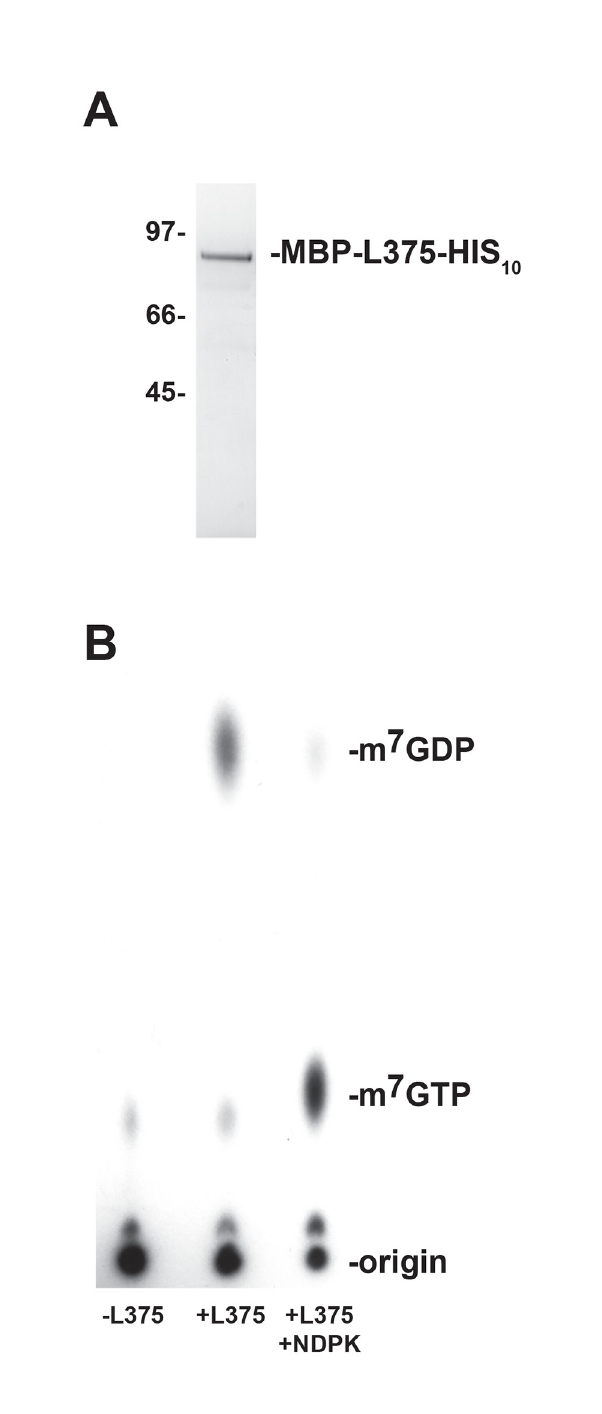
Fig 2. Recombinant Mimivirus L375 hydrolyzes the mRNA cap. (A) An MBP-L375 fusion protein containing a C- terminal 10X histidine epitope tag (MBP-L375-HIS 10 ) was synthesized in Escherichia coli and purified by affinity chromatography through successive amylose and nickel-nitrilotriacetic acid columns. The purified MBP-L375-HIS 10 protein was separated by SDS/PAGE and visualized by Coomassie blue staining. The locations of the protein mass standards (in kDa) are labeled on the left side of the gel and the ~87 kDa MBP-L375-HIS 10 protein is denoted on the right. (B) MBP-L375-HIS 10 (80 ng) and 0.02 pmol 32 P-cap-labeled actin RNA were added to decapping buffer and incubated at 37˚C for 30 min. After the incubation, an aliquot of the reaction was treated with 2 U of nucleoside